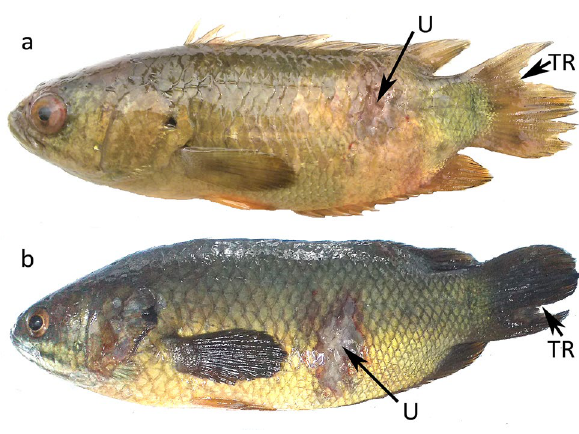
Figure 2. Tail-rot (TR) and Ulcerations (U) on body of Anabas testudineus experimentally-challenged with bacteria ( a ) Aeromonas hydrophila (AM-31) and ( b ) A. jandaei